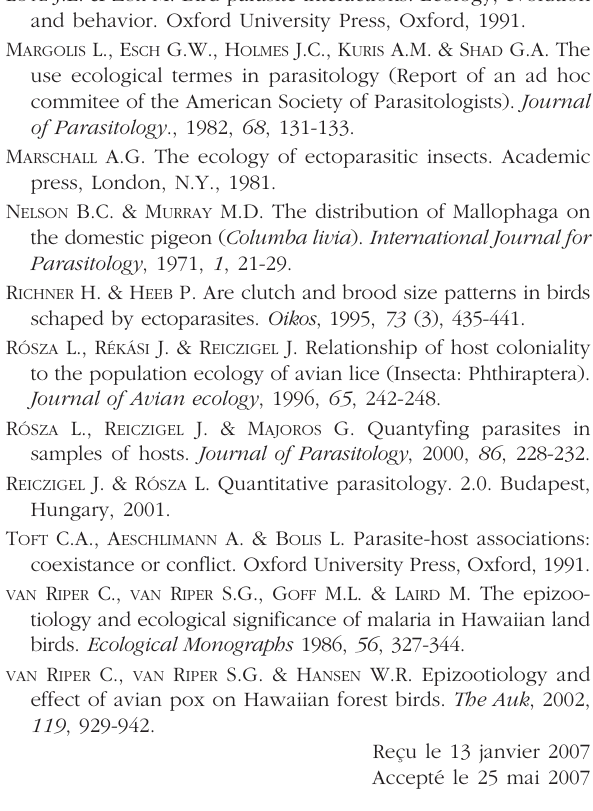
Tableau III. – Distribution et abondance des cinq espèces de